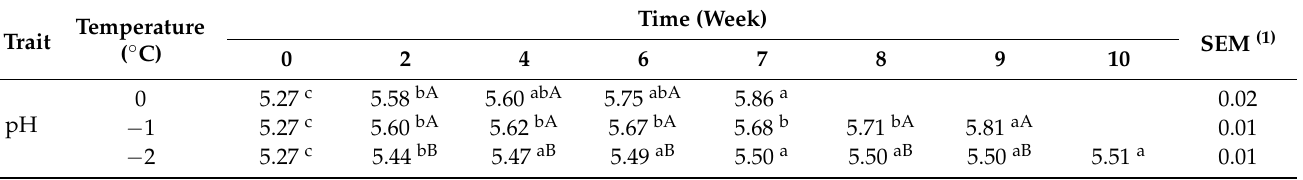
Table 2. pH of dry-aged beef loin on 0, − 1, − 2 ◦ C temperature electric field refrigerate